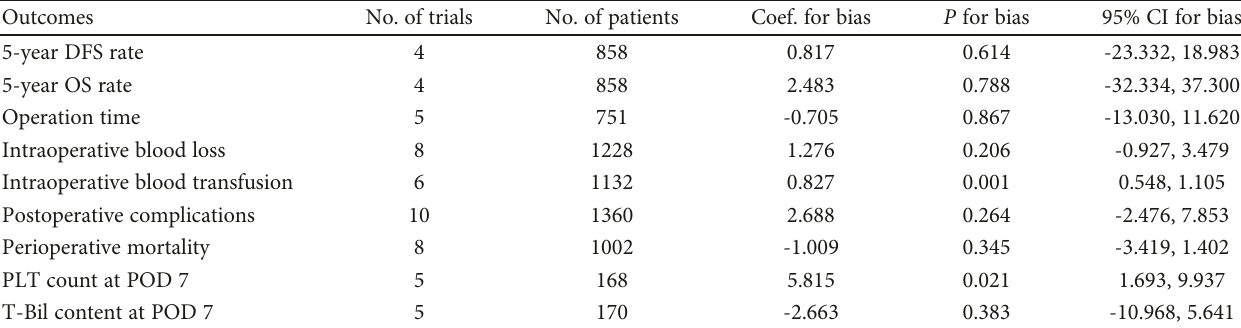
Table 3: Egger ’ s publication bias test for e ff ects of HS vs. HA in the treatment of patients with HCC and hypersplenism.